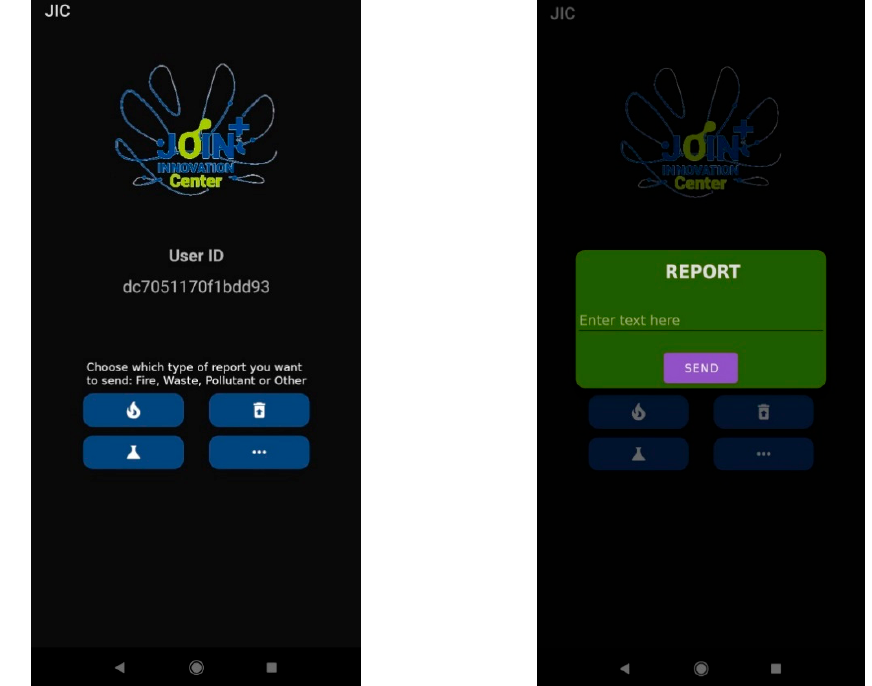
Figure 2. Details of the mobile application to report a dangerous situation.